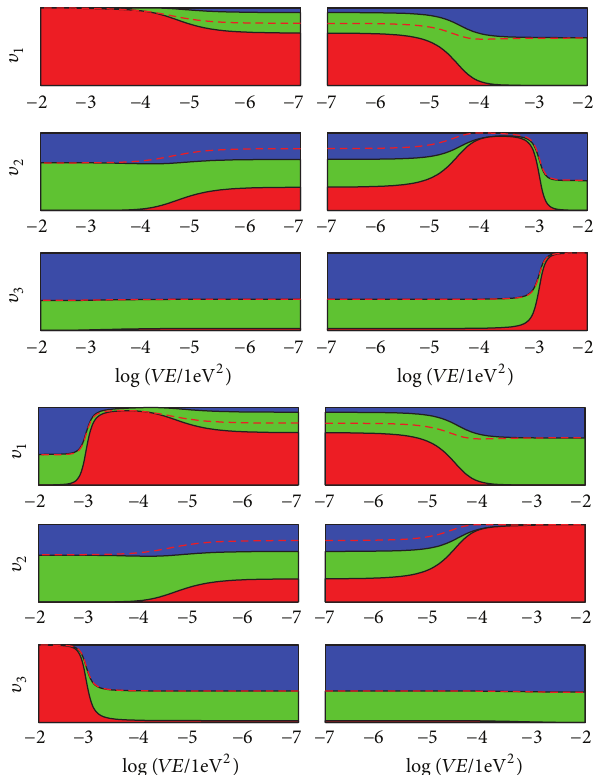
Figure 2: The flavor contents of the eigenstates of the Hamiltonian in matter as functions of 𝐸𝑉 . The vertical width of the band is taken to be 1, then the vertical sizes of the colored parts give |𝑈 𝑒𝑖 | 2 (red), and |𝑈 𝜇𝑖 | 2 (green), |𝑈 𝜏𝑖 | 2 (blue). The right and left panels correspond to neutrinos and antineutrinos, respectively. We take the best fit values of [21] with 𝛿 = 0 . Variations of 𝛿 change the relative ] 𝜇 and ] 𝜏 contents. The dashed red line shows a shift of border between and ] 𝜏 flavors for 𝛿 = 𝜋 . The upper (lower) panel corresponds to normal (inverted) mass